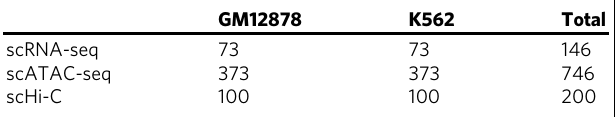
Fig. 3d. For example, { Lhx1 , Neurod1 }, { Gata4 , Sox17 , Foxa2 } and { Rfx4 , Sox3 } are high ranking speci fi cally in subpopulations 1, 2 and 3 respectively, while Pou3f2 and several Hox genes are high ranking in both subpopulations 1 and